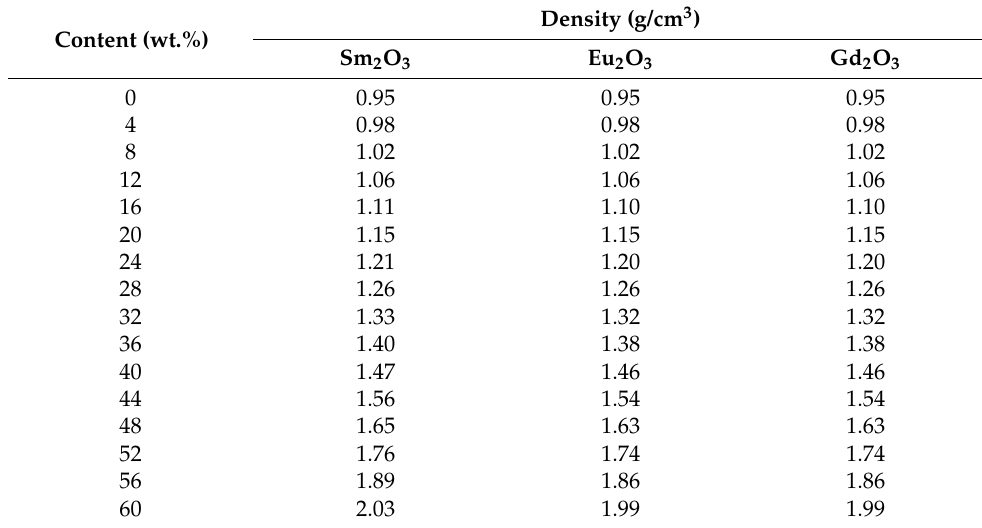
Table 4. Densities of Sm 2 O 3 /HDPE, Eu 2 O 3 /HDPE, and Gd 2 O 3 /HDPE composites with filler contents varying from 0 to 60 wt.% (in 4 wt.% increments), calculated using Equation (5). Density (g/cm 3 Content (wt.%)